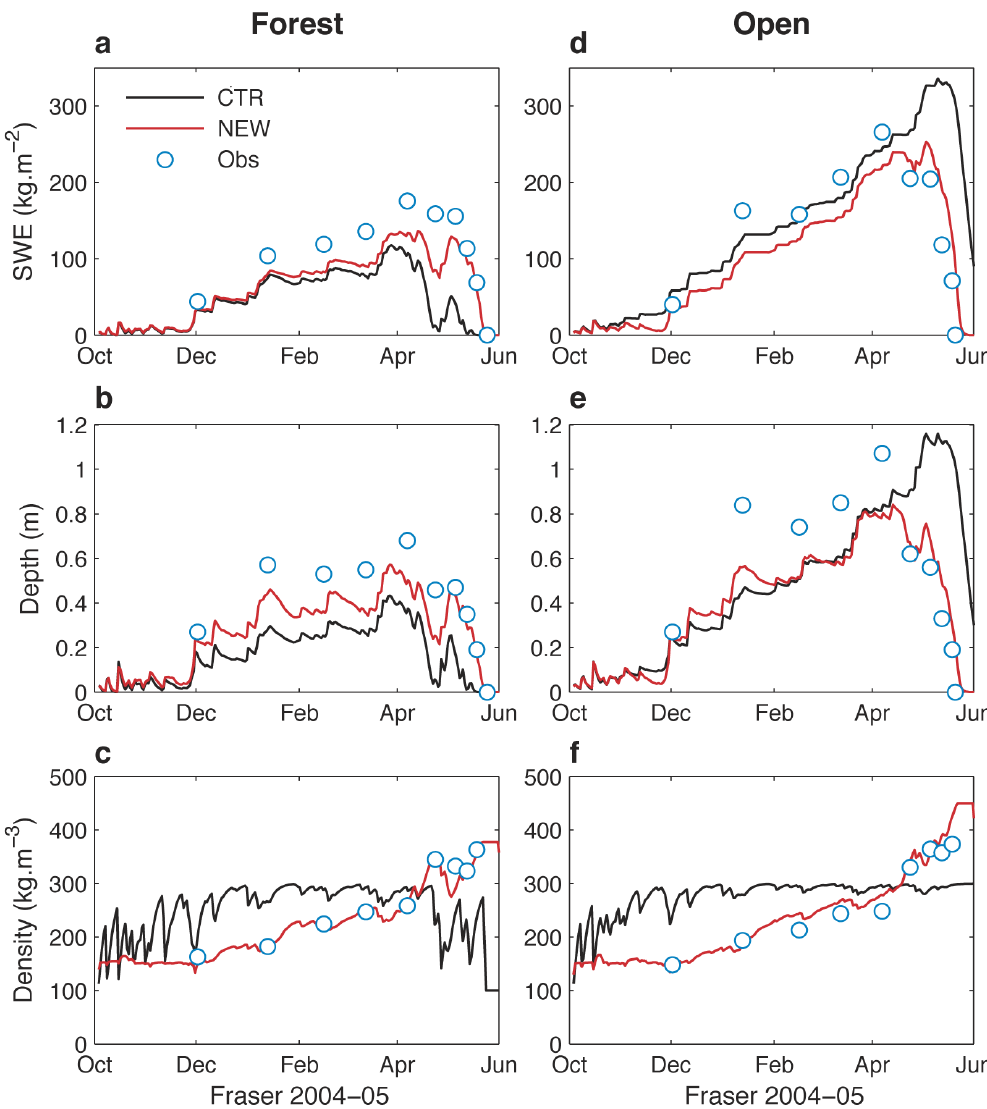
Figure 9. Offline simulation results with the older (CTR ECMWF) snow scheme (black line—before 2009 revision), and NEW (red line—after 2009 revision) for the 2004–2005 winter season at Fraser forest ( a – c ) and open ( d – f ) sites. Snow mass ( a , d ), snow depth ( b , e ) and snow density ( c , f ) are shown, with time on the x -axis (from 1 October 2004 to 1 June 2005). Observations are represented by open blue